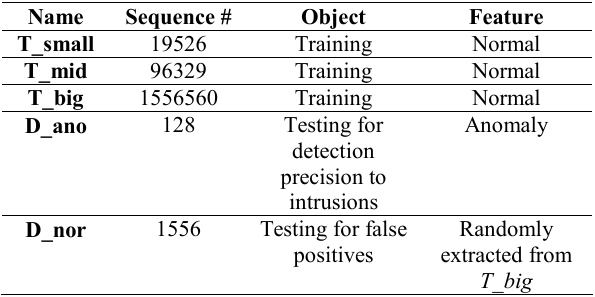
Table 1. Datasets and their features.